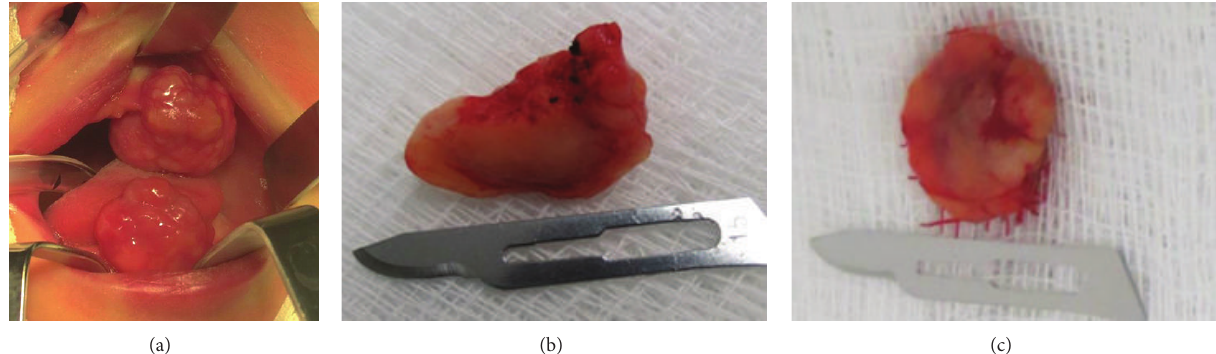
Figure 1: Clinical and macroscopic features. (a) Two pedunculated reddish nodules located in the mandible and maxilla. ((b) and (c)) The lesions following surgical excision.